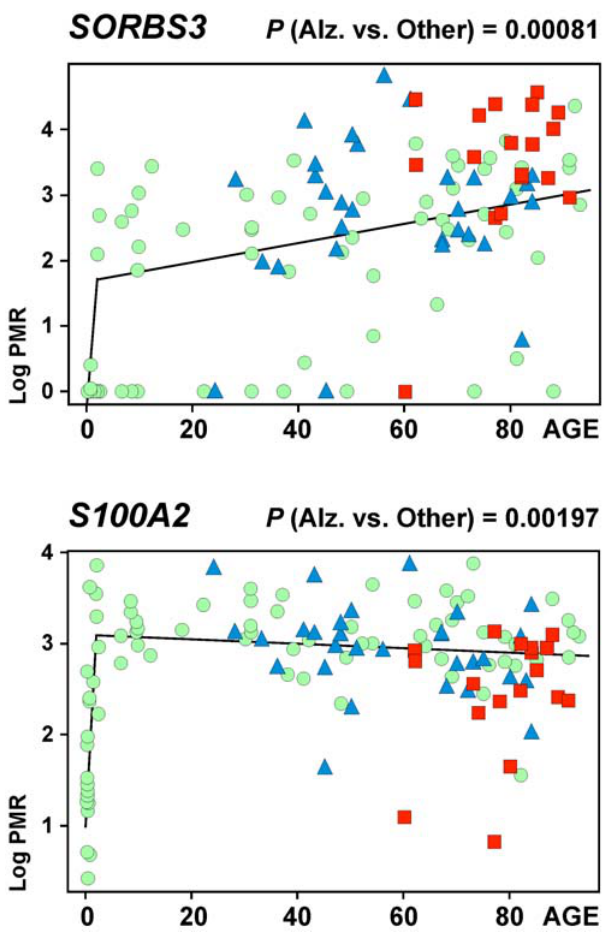
Figure 3. Acceleration of age-associated DNA methylation changes in Alzheimer’s disease. Scatter plots showing age-associated methylation changes for SORBS3 and S100A2 across all ages. N=125 subjects, including Alzheimer subjects (red squares), schizophrenics (blue triangles) and controls (green dots). P-values refer to T-tests for comparison of Alzheimer subjects versus all other subjects older than 60 years. One outlier (ID 2763, 104 years old, Table S4) was omitted from the age-associated